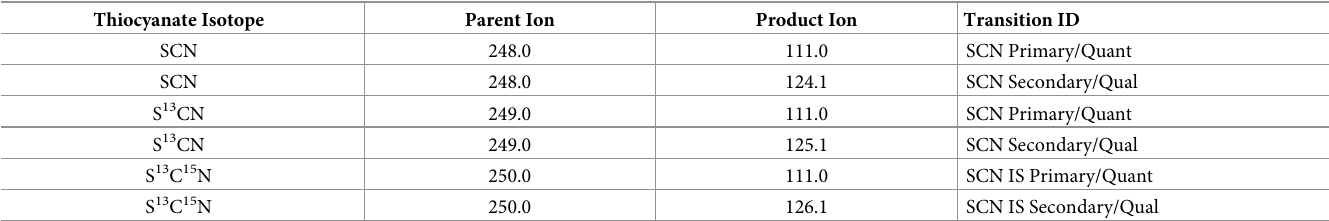
Table 2. Transitions used for selected reaction monitoring (SRM) for LC-MS/MS data acquisition and processing used in exposures 3 and 4. Thiocyanate